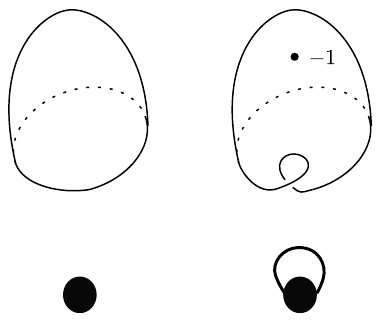
Figure 5. Redundant pair of